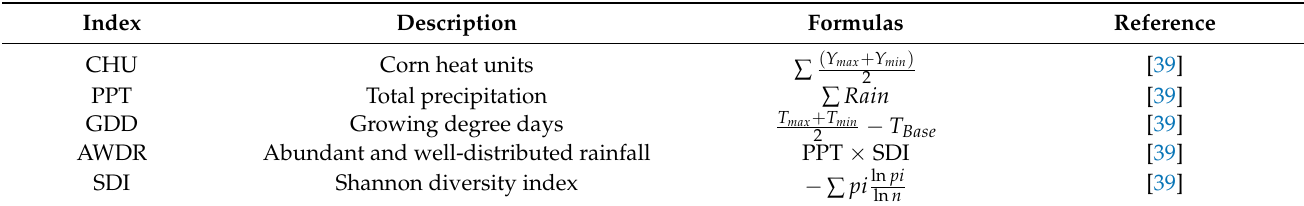
Table 2. The weather variables and the calculation formulas used in this